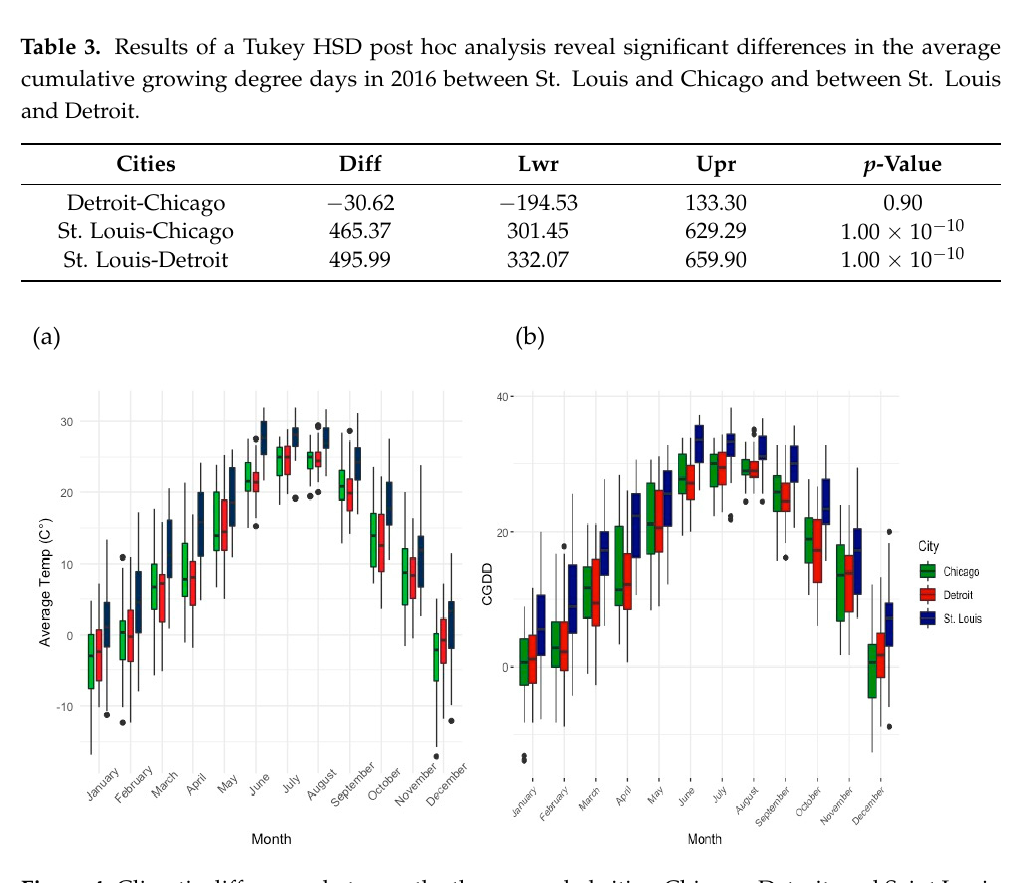
Table 4. The results of the linear model with head width as the response variable and month and city as interacting fixed effects indicate significant relationships between bee head with and city climate.